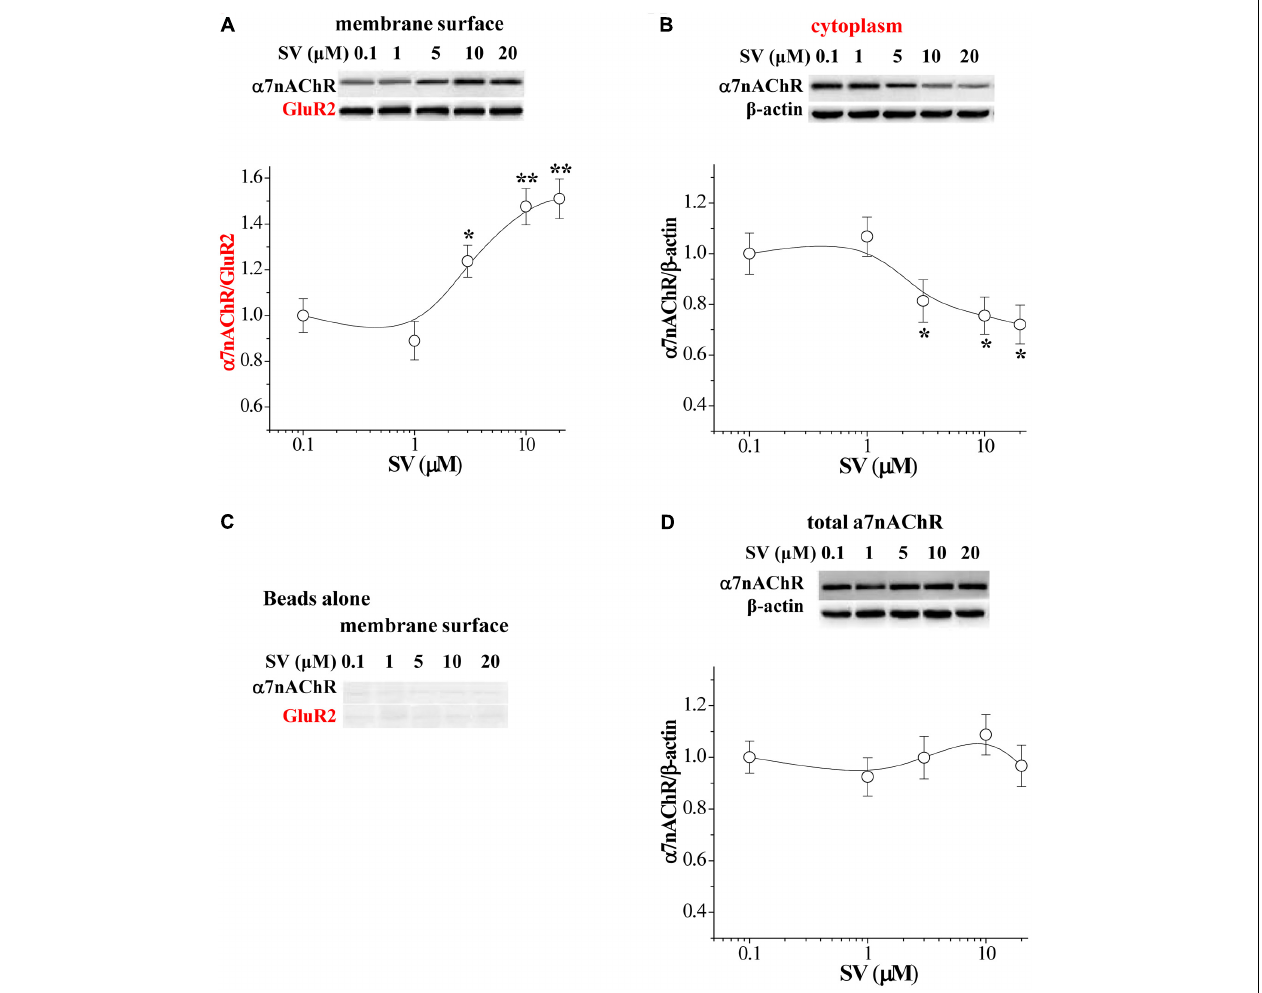
FIGURE 2 | Acute treatment of SV enhances the trafficking of α 7nAChR. (A,B) Representative Western blots of cell membrane surface (surface) and cytoplasmic α 7nAChR protein in hippocampus. Biotin/beads: biotinylated samples. Graphs indicate the mean levels of surface α 7nAChR (A) and cytoplasmic α 7nAChR (B) in control and SV-treated hippocampus. Surface α 7nAChR was normalized by surface GluR2 protein and cytoplasmic α 7nAChR was normalized by β -actin, which was again normalized by vehicle-treated group. ∗ p < 0.05 and ∗∗ p < 0.01 vs. control slices (two-way ANOVA). (C) “Beads alone” indicates non-biotinylated samples as a negative control. (D) Total α 7nAChR protein was normalized by β -actin, which was again normalized by vehicle-treated